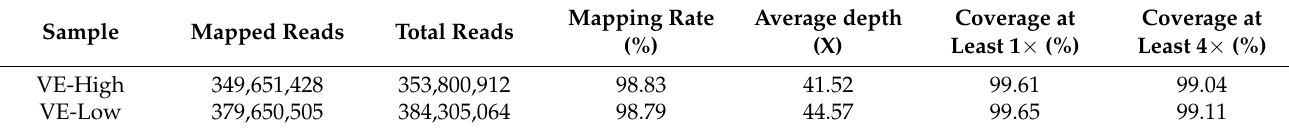
Table 2. Sequencing depth and coverage statistics.